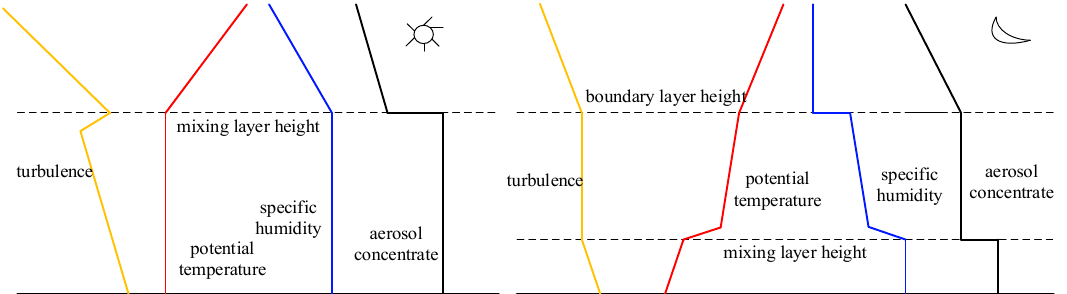
Figure 1. A simplified scheme of diurnal cycle of atmospheric boundary layer (ABL) in clear-sky situations (adapted from Stull [1]). Solid line marks the height of ABL (ABLH), the dashed line marks the top of residual layer (RL). The entrainment process near the top of ABL is marked by the dashed arrows. SBL, stable boundary layer; CBL, convective boundary layer; EZ, entrainment zone; RL, residual layer; EMT, early morning transition; EET, early evening transition.